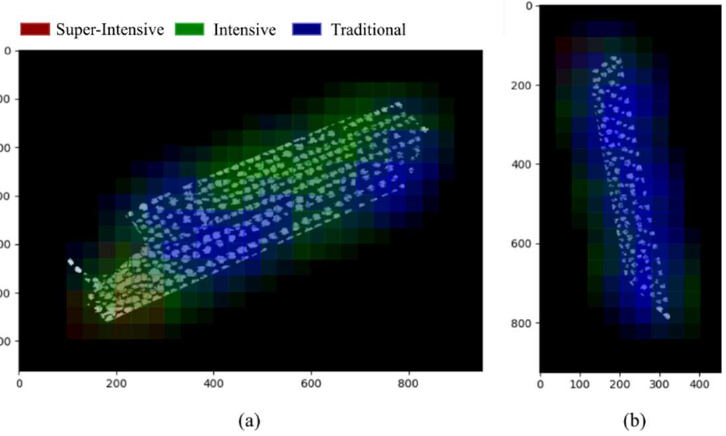
Figure 10. Example of a common misclassification for a grove. ( a ) Intensive olive groves where areas of traditional olive groves can be identified. ( b ) Traditional olive groves where areas of intensive olive groves can be